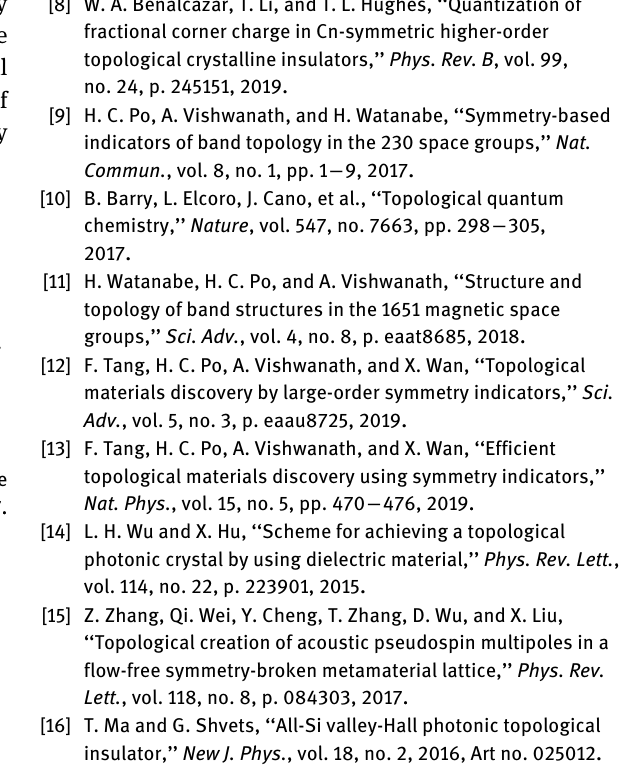
Figure B1: The effects of different truncations on supercell’s projective band. For example 1, (a) the supercell’s Γ X projective band under the ), where the edge states are denoted as red-triangle points and the insert diagram is the illustration of the truncation truncation T = (0 , T 2 , T ); (b) the supercell’s Γ Y projective band under the truncation T = ( T treatment T = ( T 1 2 = T and (d) the evolution of corner states with respect to vacuum defects (circle defects with radio radius r in under the truncation T = T 1 2 four boundaries). Here, the corner states are denoted as red-triangle